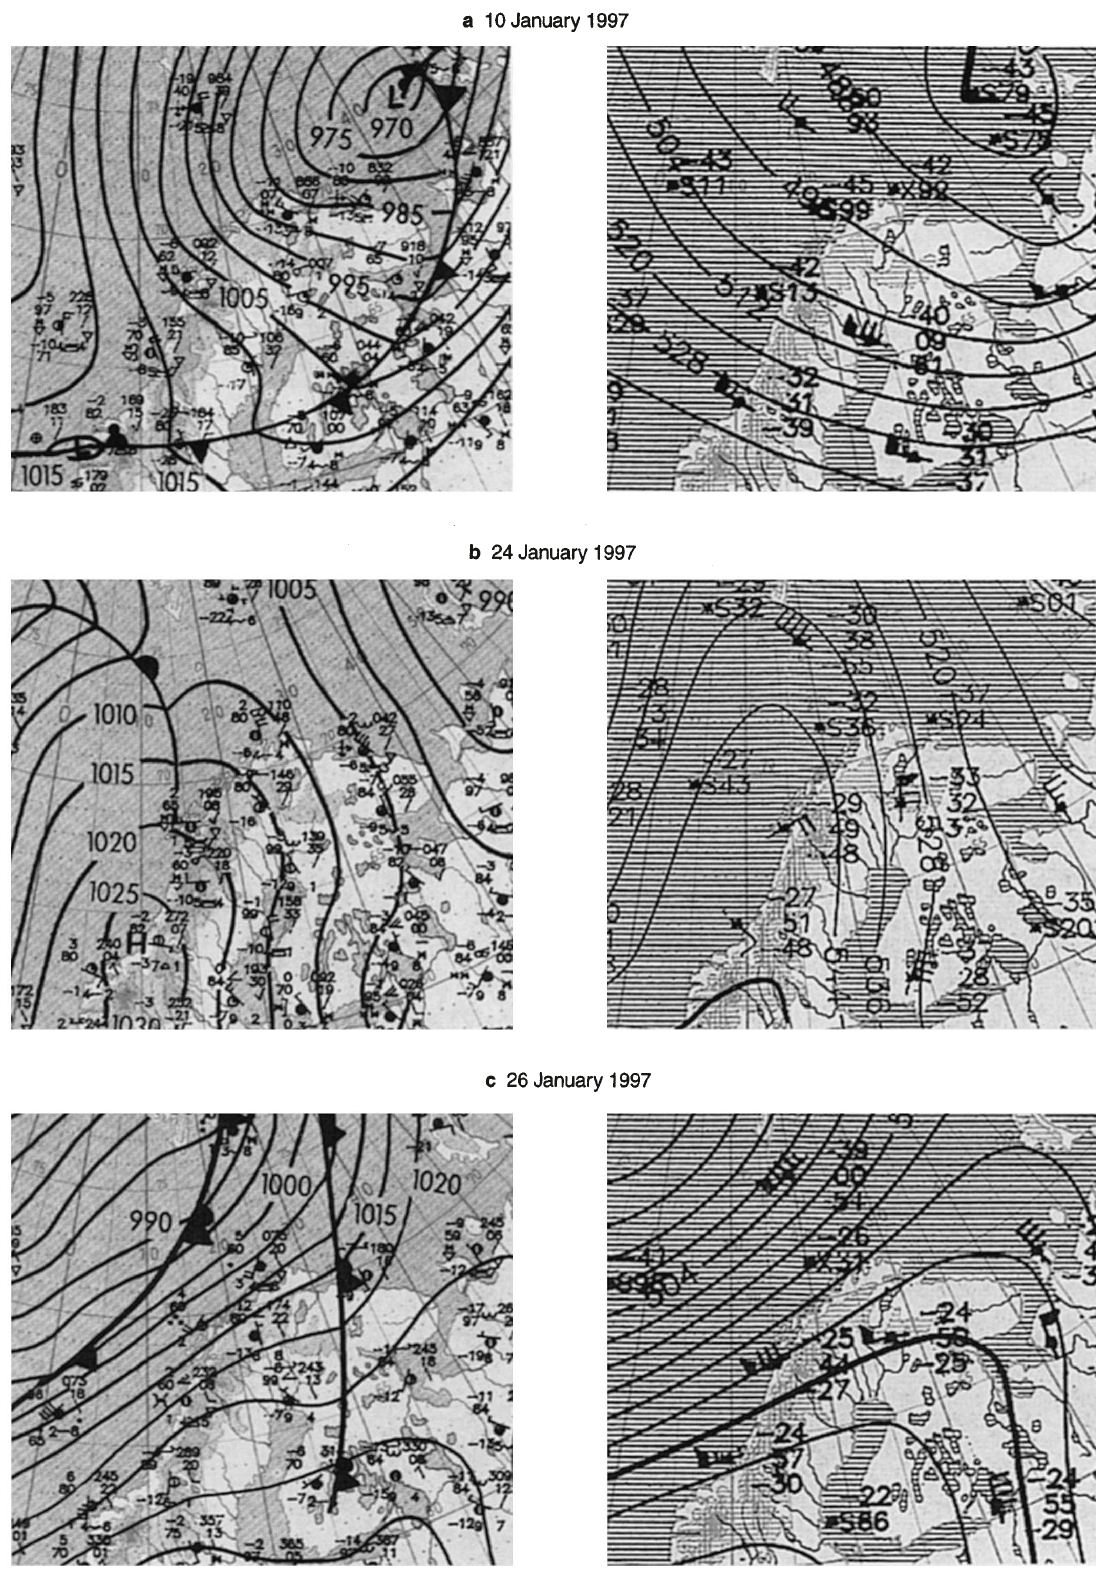
Fig. 6. Synoptic maps at surface ( left ) and at 500 hPa ( right ) of wind and temperature fields in northern Scandinavia; a for 10 January b for 24 January c for 26 January. The maps are from the European Meteorological Bulletin and published by Deutscher